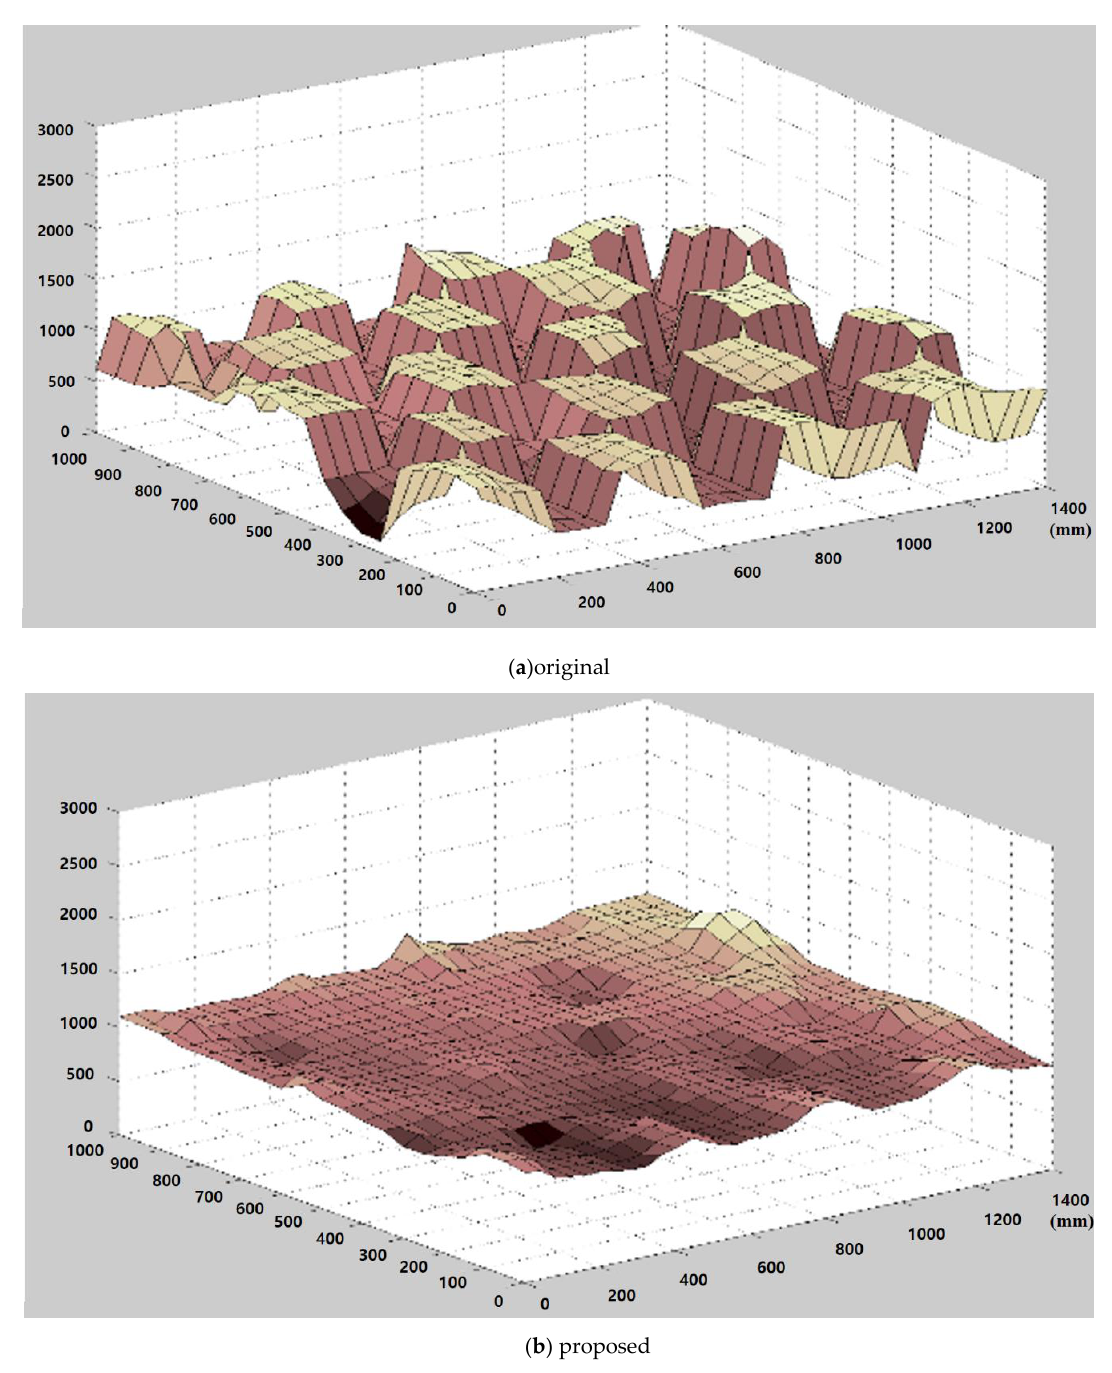
Figure 14. Three-dimensional surface plot using zoomed-in depth.